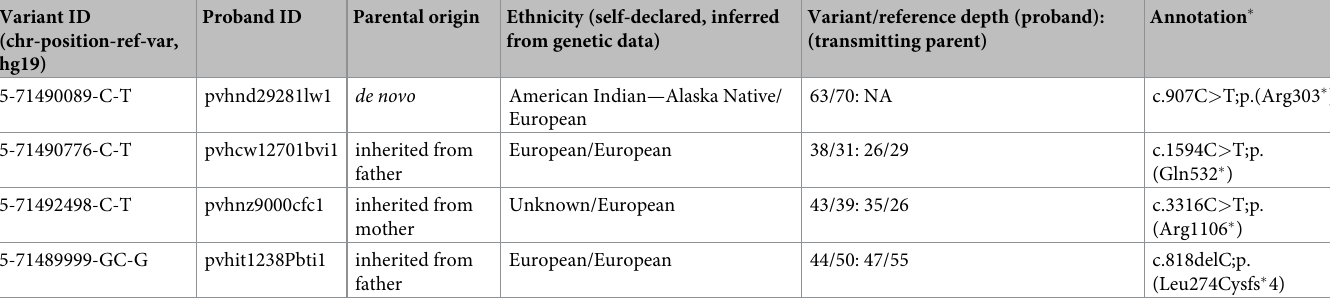
Table 3. MAP1B LoF qualifying variants identified in PVNH patients. Variant ID (chr-position-ref-var,